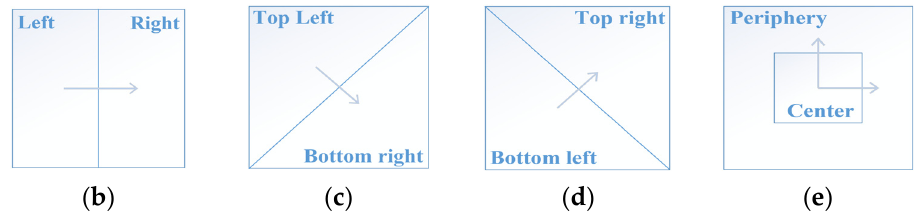
Figure 11. Division of an image in five directions: ( a ) horizontal, ( b ) vertical, ( c ) 45°, ( d ) 135°, and ( e ) center and periphery.